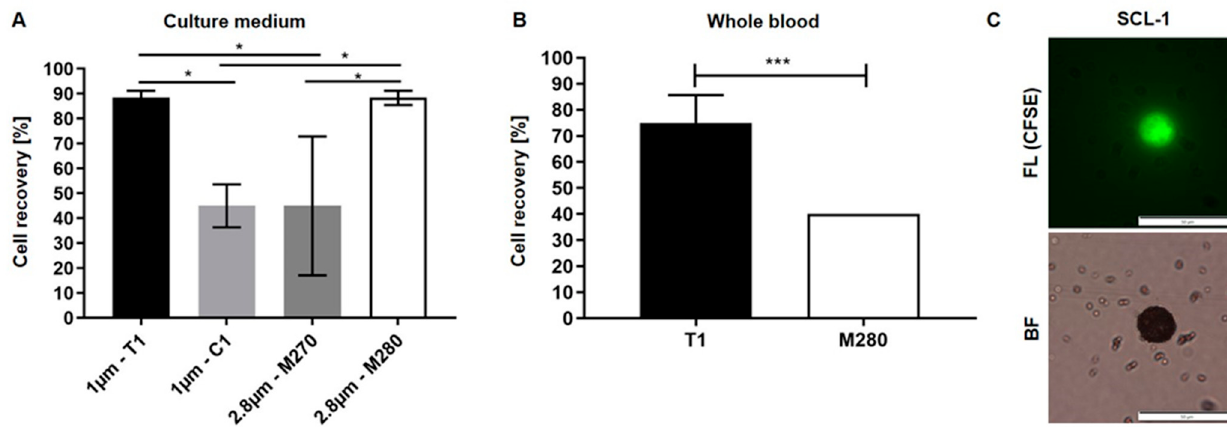
Figure 1. Enrichment of HNSCC cells from cell culture medium ( A ) and whole blood ( B ) differs depending on size and type of functionalized magnetic beads. Values are displayed as means of recovered cells using antibody-coupled magnetic beads with specific sizes and surface modifications. Twenty fluorescently labelled SCL-1 cells were spiked into 7.5 mL cell culture medium ( A ) or 7.5 mL full blood samples ( B ), and manually enriched by using EpCAM antibody coupled magnetic beads. ( A ) Welch’s t -test, n = 3, *: p < 0.05 (one-way ANOVA test with Tukey’s t -test); (B) Welch’s t -test, n = 6 (T1), n = 2 (M280), ***: p < 0.002; ( C ) recovered, CFSE-stained SCL-1 cells were analyzed by fluorescence microscopy (FL). Corresponding bright-field image (BF) shows beads bound to cell and freely distributed in the medium. Scale bar, 50 µm.